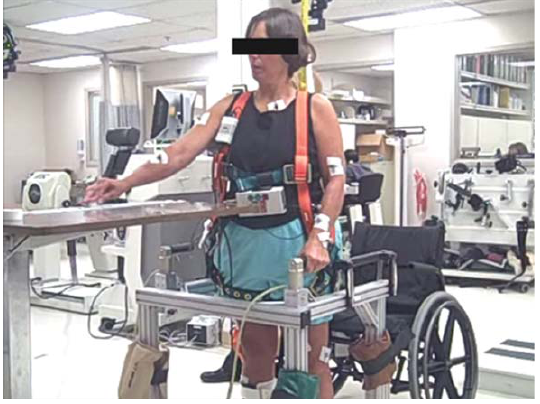
Fig. 1. Individual with complete, thoracic (T4) level spinal cord injury standing with stimulation to musculature spanning trunk and lowerextremities.Shestabilizedwithherlefthandwhileperforming manual slide-shifts of an object with her right hand. ing maintenance. Measurements from